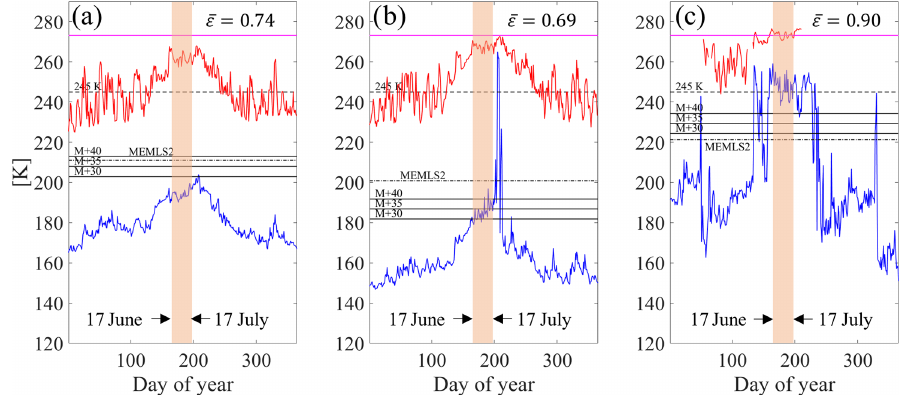
Figure 5. Time series of (blue) enhanced-resolution T b 37GHz, horizontal polarization, and (red) air temperature at the (a) Summit, (b) Humboldt and (c) Swiss Camp stations for the year 2005. Threshold values obtained with the different detection algorithms are reported as horizontal black lines (solid line, M + (cid:49)T ; dashed line, 245K; and dot-dashed line, MEMLS), and the 0 ◦ C threshold is reported as a magenta solid line. The 30d window between 17 June and 17 July is shown in the shaded orange area and reports the average estimated emissivity ( ε ) values.